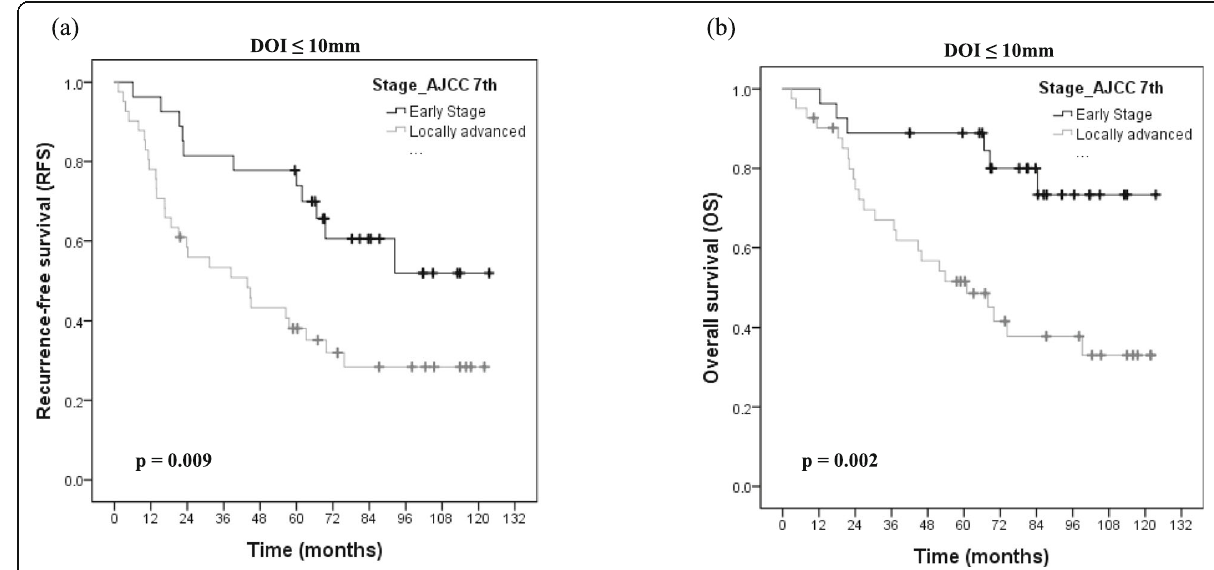
Fig. 3 Kaplan-Meier analysis showing recurrence-free survival ( a ) and overall survival ( b ) stratified by stage of disease in patients with depth of invasion. DOI less than or equal to 10